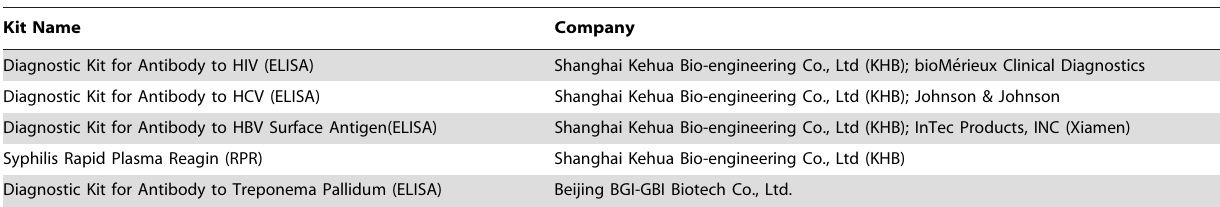
Table 1. Reagents and company used in donor screening.